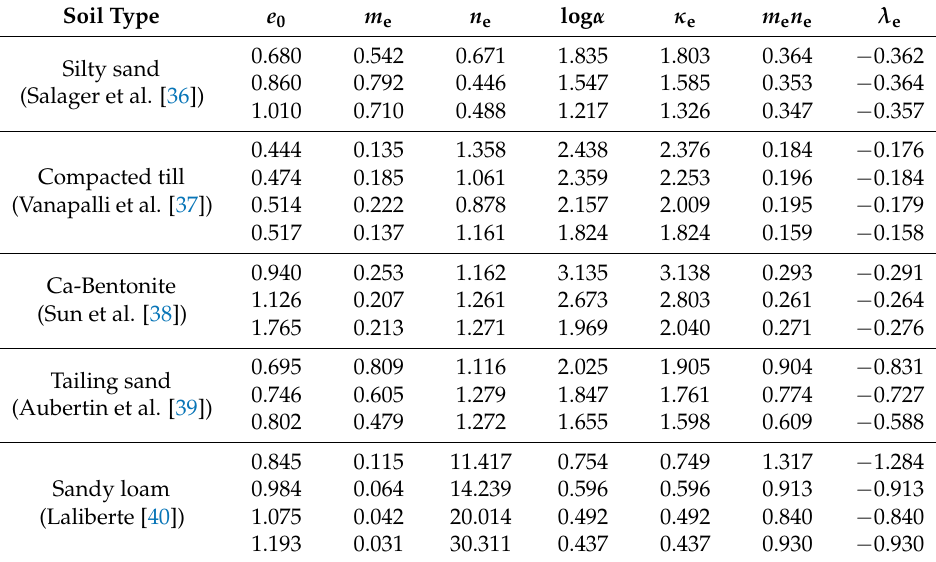
Table 2. Values of the parameters on the plane e.